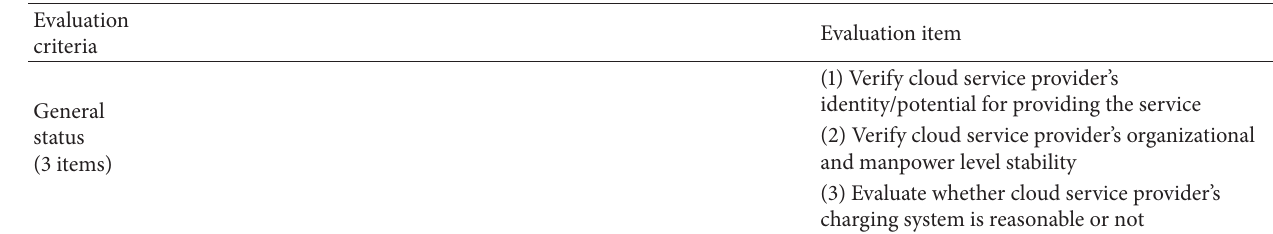
Table 10: Evaluation items of general status.